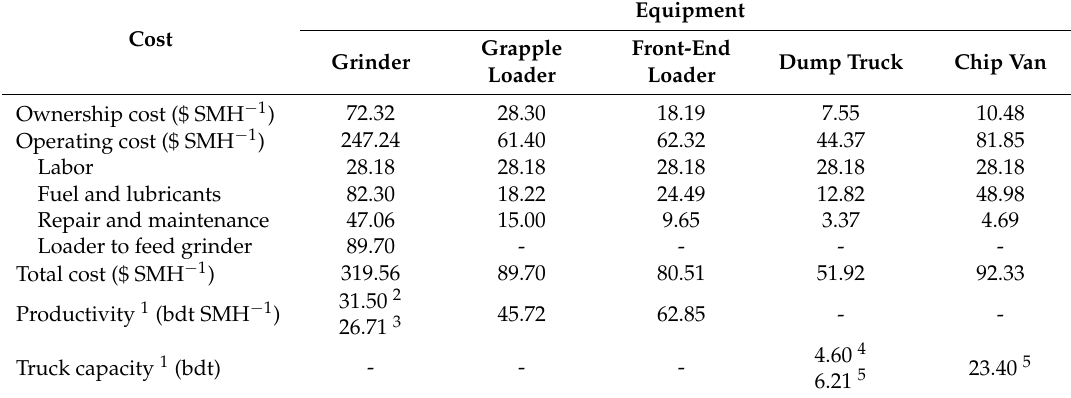
Table 3. Hourly cost and productivity of equipment and truck capacities used in the model applications. Equipment Cost Grapple Grinder